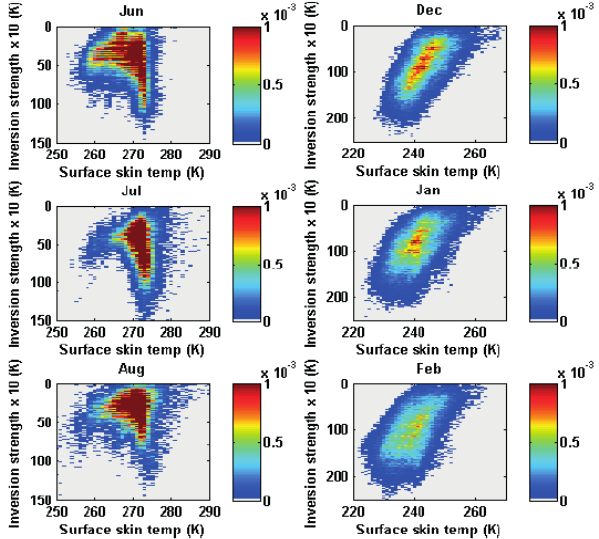
Figure 2. Histograms of inversion strength and surface temperature for summer (left column) and winter (right column) months in the Arctic, based on Atmospheric Infrared Sounder data. Note that the x and y axes are different for summer and winter months and inver- sion strength is multiplied by 10. Each temperature–temperature bin is normalized by the total number of observations in the entire his- togram. Reproduced with permission from Devasthale et al.